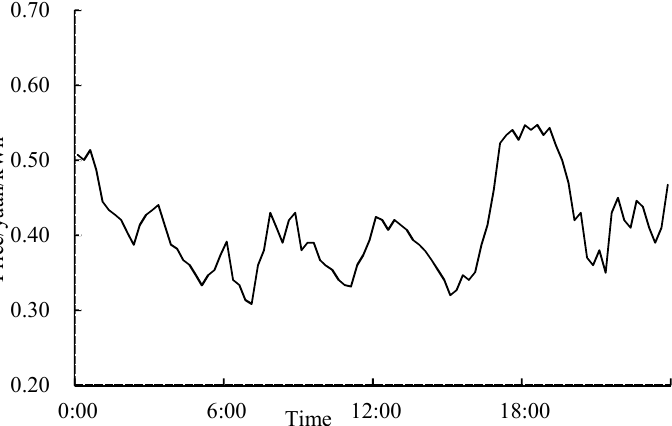
Figure A1. Real-time electricity price curve.